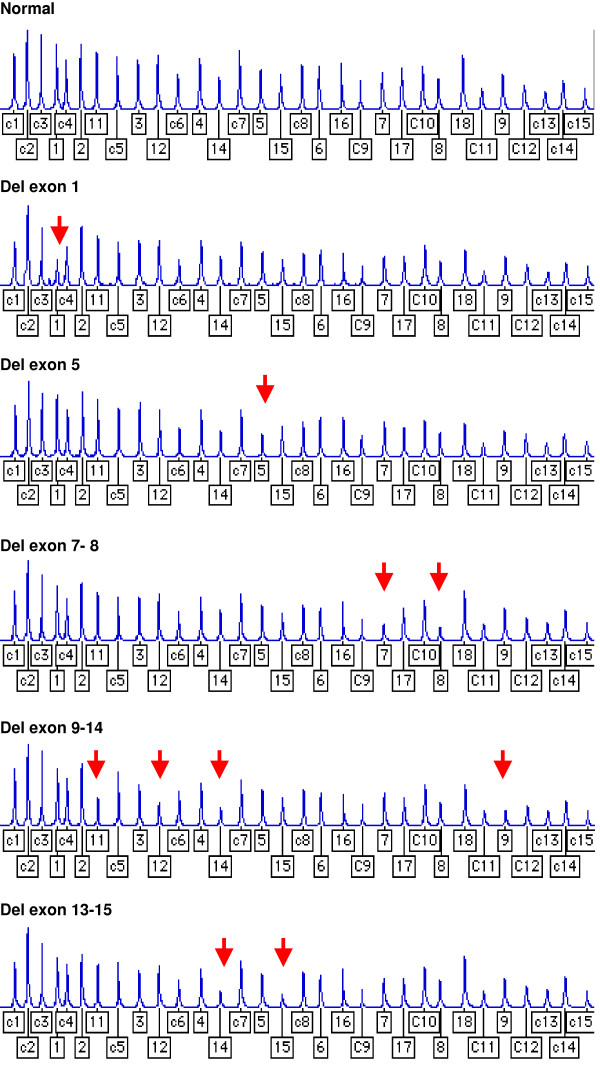
Graphical results of MLPA analysis. Peak profiles of the MLPA analysis in one normal individual and in the five patients with the deletions described in the results section.